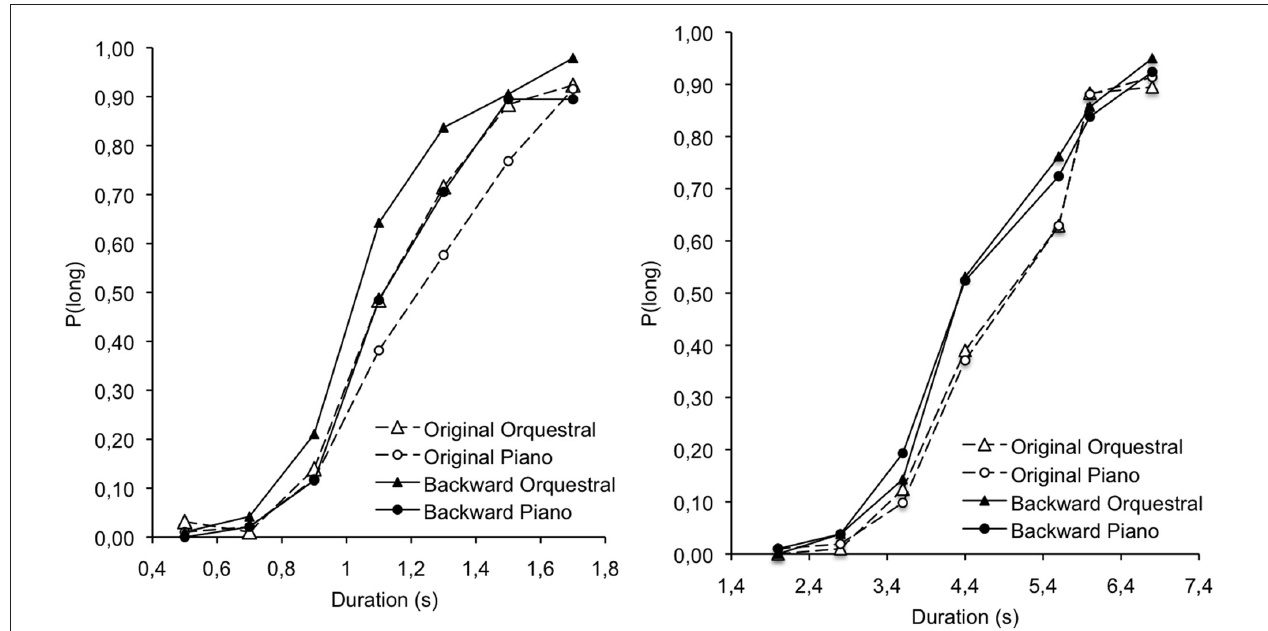
FIGURE 2 | Proportion of long responses plotted against stimulus duration for the original and the backward version of orchestral and piano music in the 0.5–1.7 and the 2.0–6.8s duration conditions.